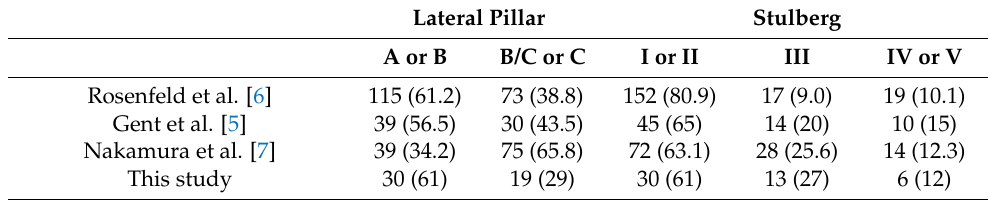
Table 5. Comparison of the disease severity with the final outcome in previously reported